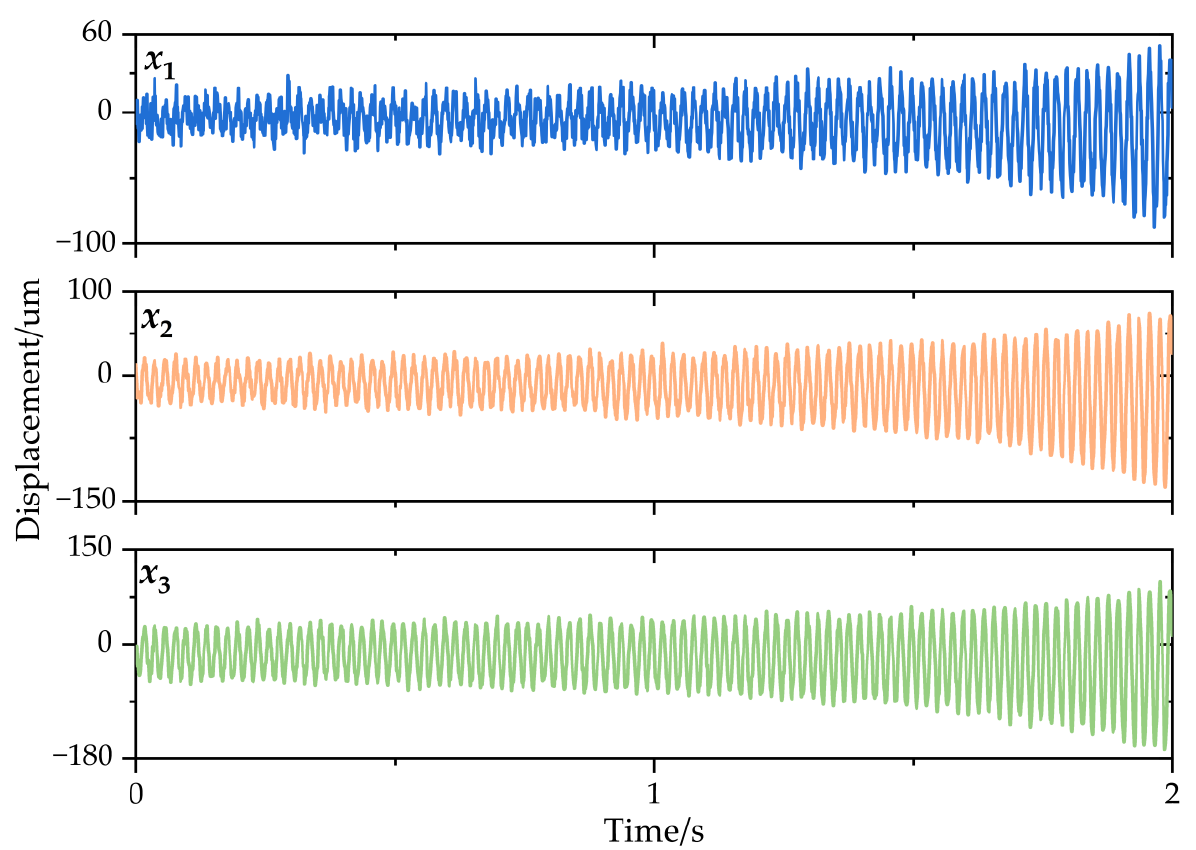
Figure 6. Displacement response of the 3-DOF time-varying structure.